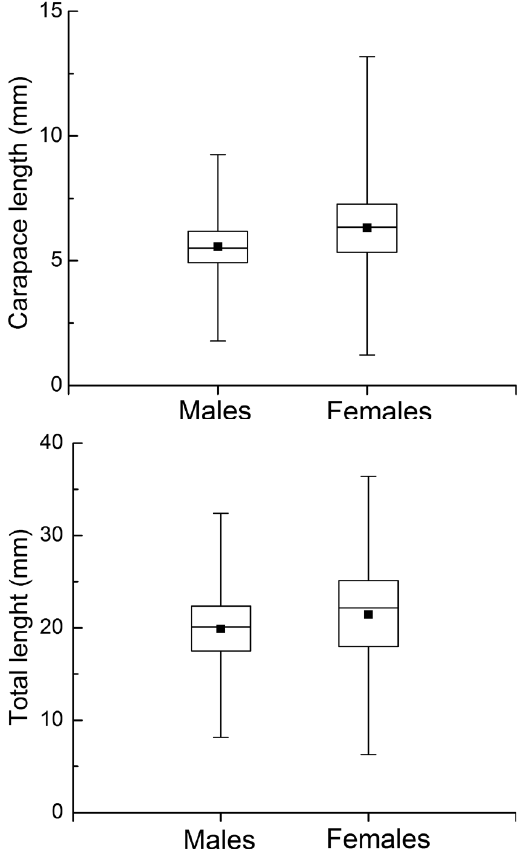
Figure 5. Minimum, maximum (whiskers), median (horizontal line) and mean (black square) carapace and total length values for males and females of Palaemon pandaliformis collected from September 2009 and August 2010 in Salsa River, Canavieiras, Bahia, Brazil.